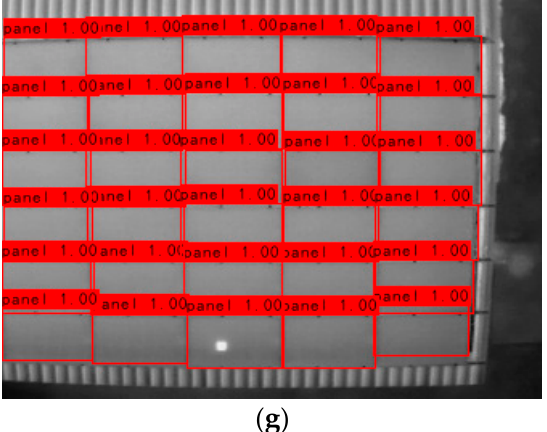
Figure 9. Visualization results from object detection on the same image. ( a ) Our method. ( b ) YOLOv3. ( c ) YOLOv4. ( d ) YOLOv5m. ( e ) YOLOv5l. ( f ) YOLOv5x. ( g ) Faster